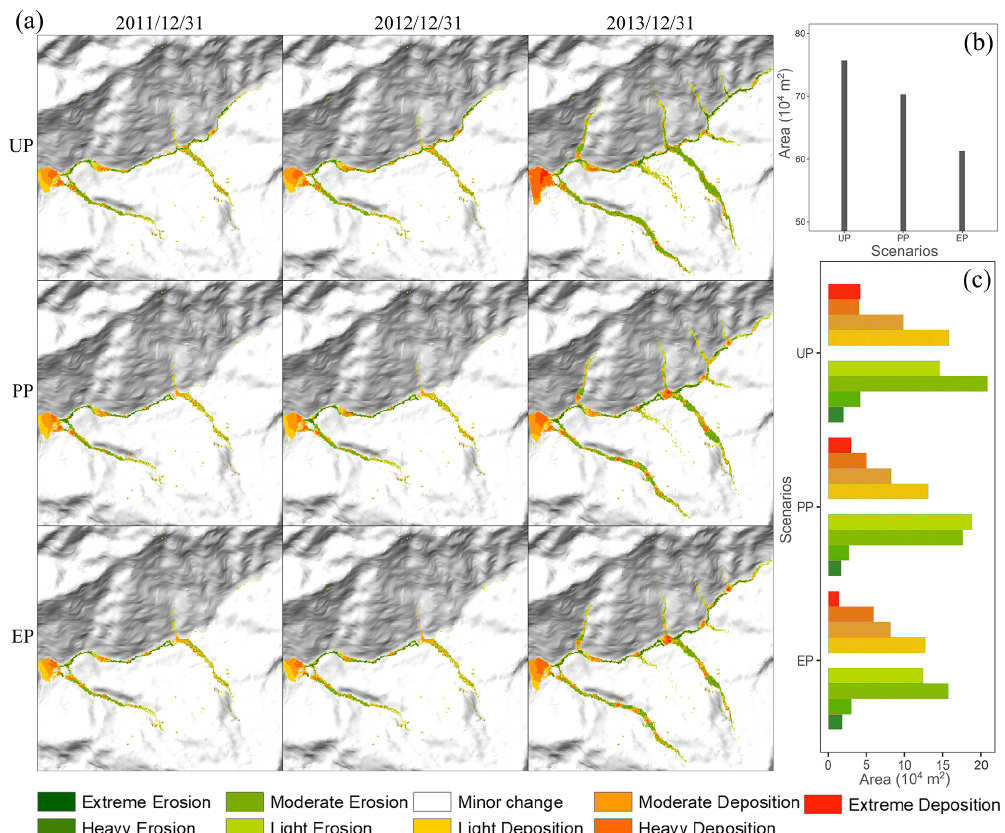
Figure 6. (a) Simulated geomorphic changes over time for the three scenarios, (b) the affected area of deposition and erosion for the three scenarios and (c) the columnar distribution of different erosion and deposition